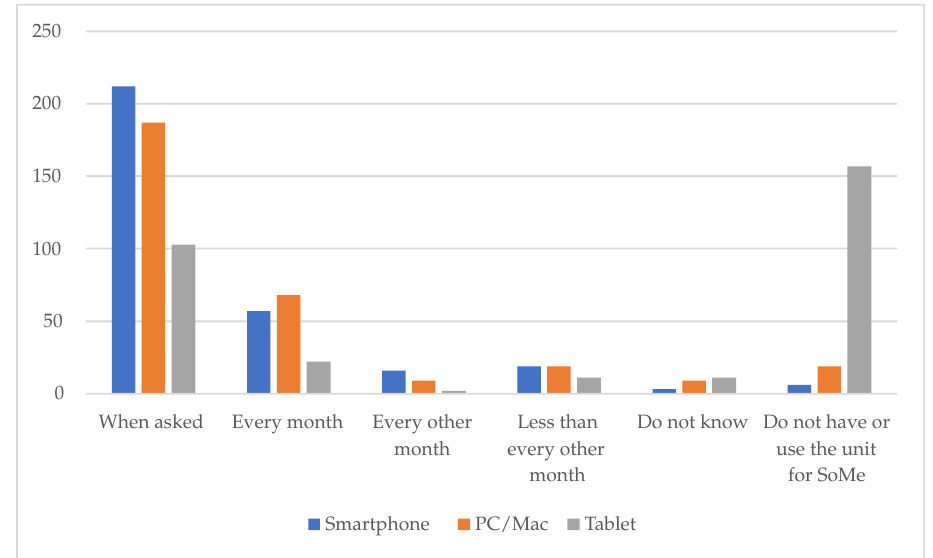
Table 8. Self-rating differences between the self-assessment